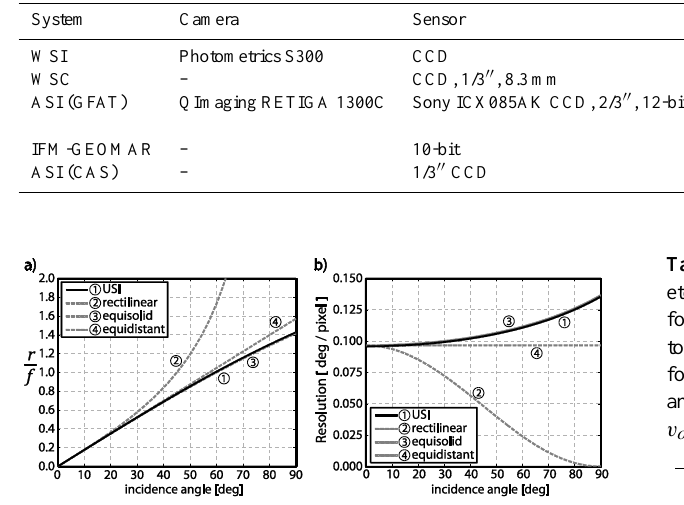
Table 1. Research camera systems for sky atmospheric observations.